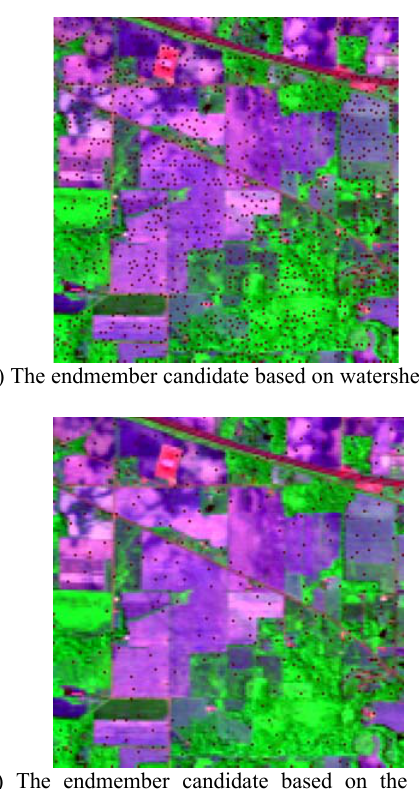
Figure.1. (a) The false color composition of original